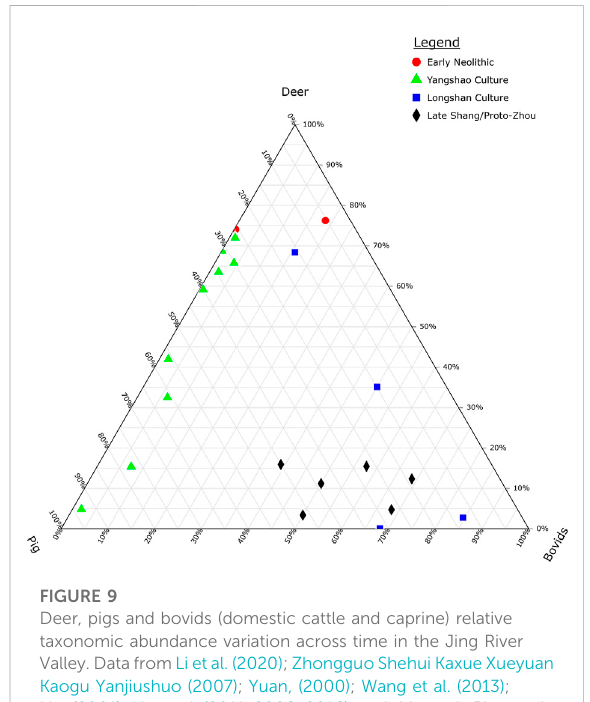
FIGURE 9 Deer, pigs and bovids (domestic cattle and caprine) relative taxonomic abundance variation across time in the Jing River Valley.DatafromLietal.(2020);ZhongguoShehuiKaxueXueyuan Kaogu Yanjiushuo (2007); Yuan, (2000); Wang et al. (2013); Hu, (2001); Hu et al. (2011, 2008, 2016), and this study Plot made with TernaryPlot